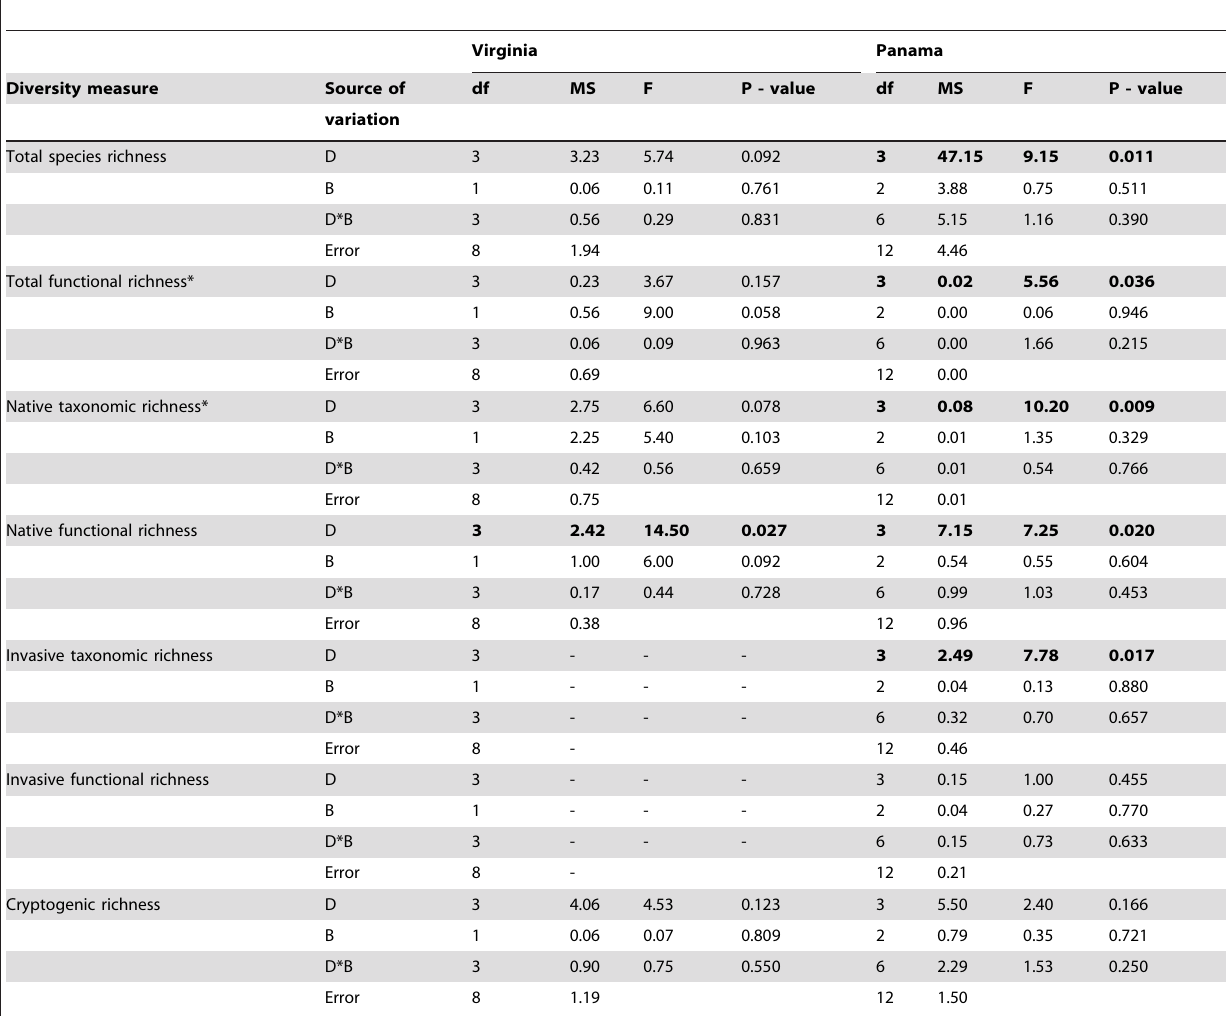
Table 2. Results from the 2-factorial ANOVA on different diversity measures for Virginia and